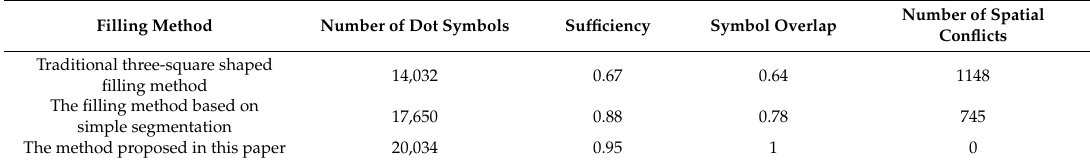
Table 1. Comparative analysis of the reliability of methods applied to a large data